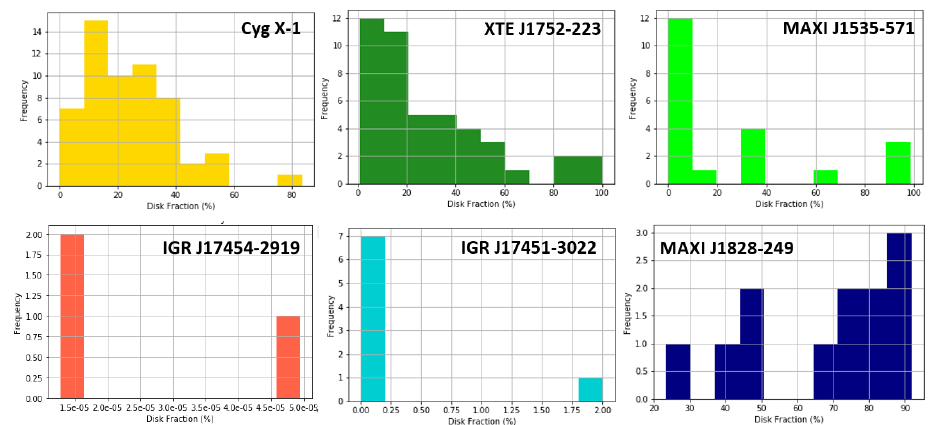
Fig. 4. Distribution of disk component flux to total flux ratio of each